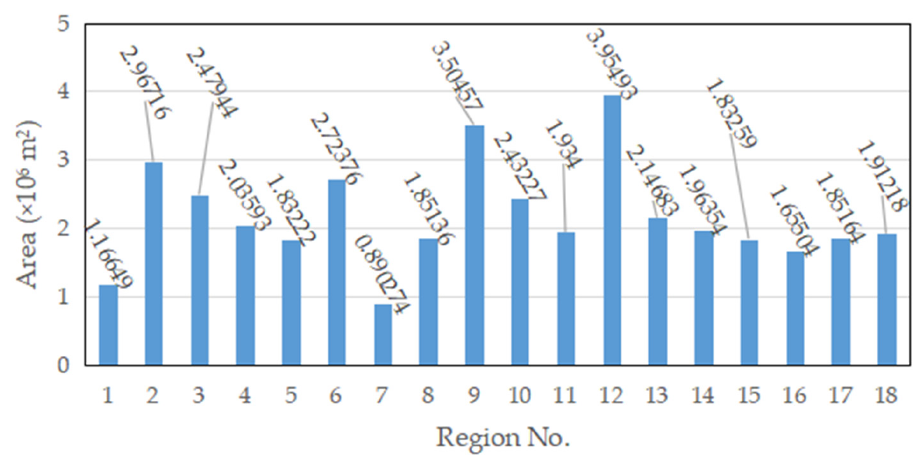
Figure A1. Area of Each Region.